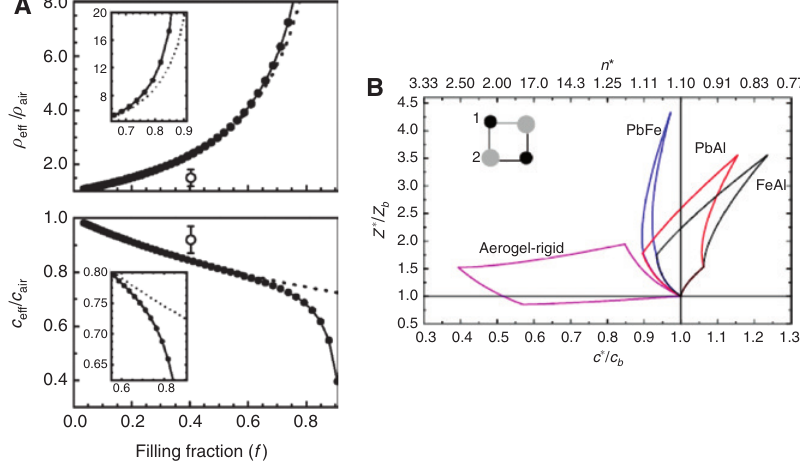
Figure 1: Effective elastic parameters of sonic crystals. (A) Effective mass density and effective sound velocity for a circular cluster consists of 151 rigid cylinders embedded in air. The black dots stand for the results from the multiple scattering simulations in Eq. (1), and the dashed lines are values obtained from Eq. (2) [83]; (B) Impedance-velocity diagram of sonic crystals consist of square lattice of solids 1 and 2 cylinders in air. Insert shows the unit cell